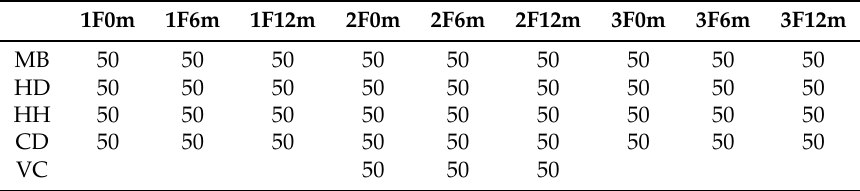
Table 1. The number of data in the inter-floor noise dataset for 5 types and 9 positions.